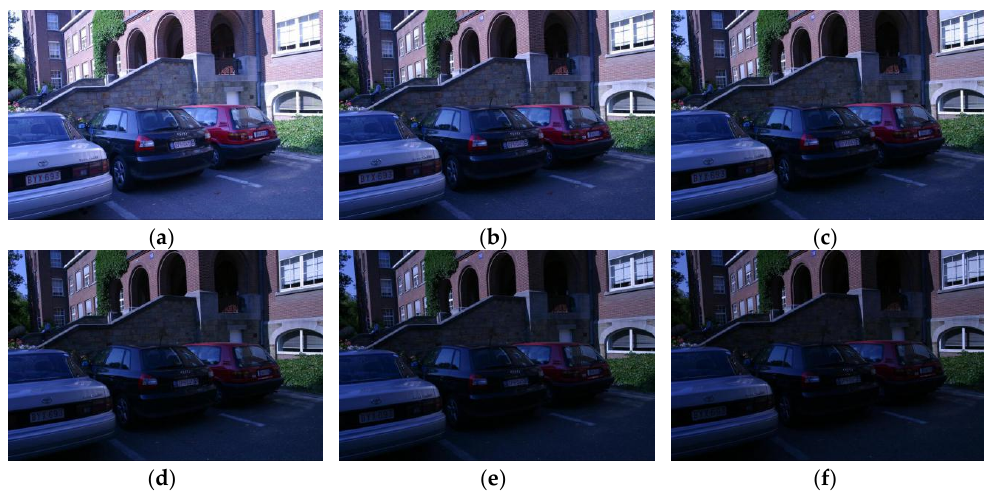
Figure 4. Leuven sequence. ( a ) Leuven 1; ( b ) Leuven 2; ( c ) Leuven 3; ( d ) Leuven 4; ( e ) Leuven 5; and ( f ) Leuven